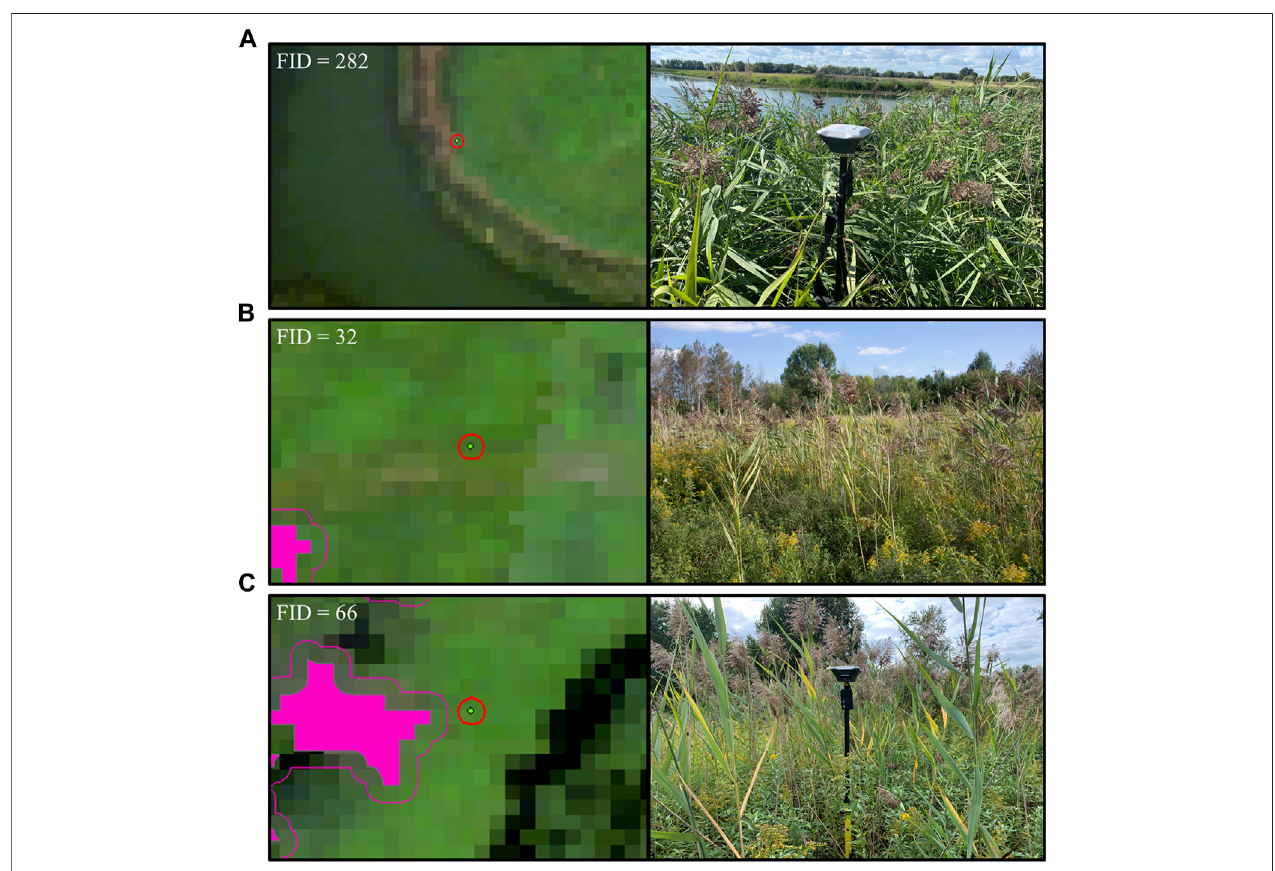
FIGURE 10 | Three validation points (FID (cid:2) 282, 32, and 66) and their 1.75 m error buffers (green dot with red circle) and associated fi eld photographs that demonstrate three ofthemostcommonscenariosthatcaused falsenegativesinthe fi naldetected Phragmites map (pink polygon with 2.25 m errorbuffer) (A) thestand was predominantly characterized by brown seed heads and stems of Phragmites along the margins of water bodies (B) the stand was a sub-pixel target and was too smalltobecorrectlyidenti fi ed (C) thepointwascollectedattheedgeofalarger Phragmites stand,wherethe Phragmites wastoosparsetocontributesubstantially to the pixels signal. The 2 m tall monopod with the EMLID Reach RS + GNSS receiver is present in sub fi gures (A,C) to provide a sense of scale.